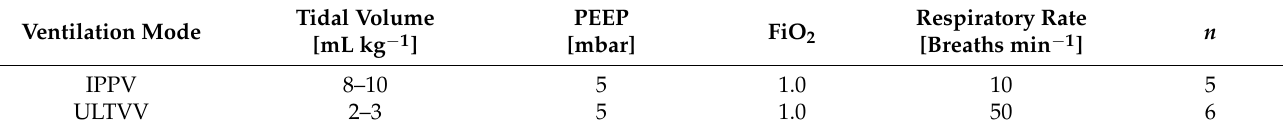
Table 1. Ventilation mode during cardiopulmonary resuscitation via Intermittent Positive Pressure Ventilation (standard ventilation) and via Ultra-low Tidal Volume Ventilation (alternative venti- lation). IPPV: Intermittent positive pressure ventilation. ULTVV: Ultra-low tidal volume ventila- tion. mL kg − 1 : Milliliters per kilogram. PEEP: Positive End Expiratory Pressure. FiO 2 : fraction of inspired oxygen. Min − 1 : per minute. n: numer of animals enlisted with sustained return of spontaneous